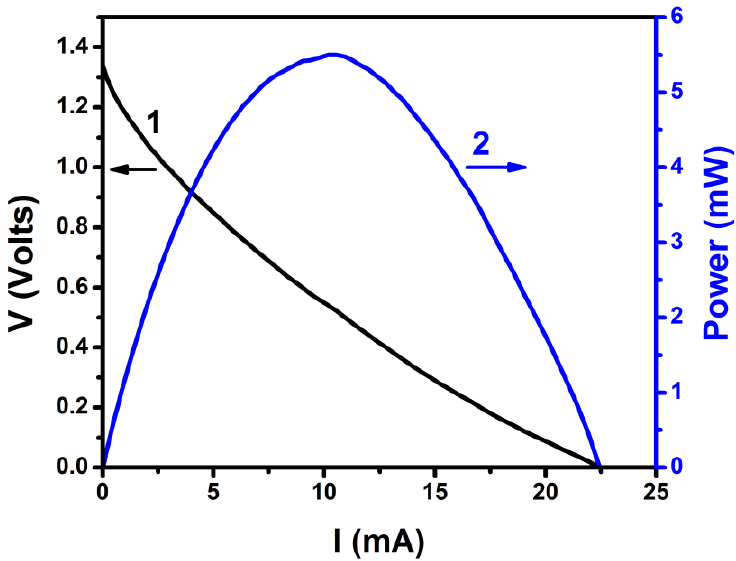
Figure 3. Current-voltage and power curve for the PFC of the present work. The cell consisted of 2 compartments and carried a ZnS / CdSe / CdS / TiO 2 / FTO photoanode and a carbon black (CB) / carbon cloth (CC) cathode. The aqueous electrolytes contained 0.25 M Na 2 S and 0.125 M Na 2 SO 3 in the anode compartment and 0.5 M Na 2 SO 4 in the cathode compartment. The active area of both electrodes was 3 cm 2 .